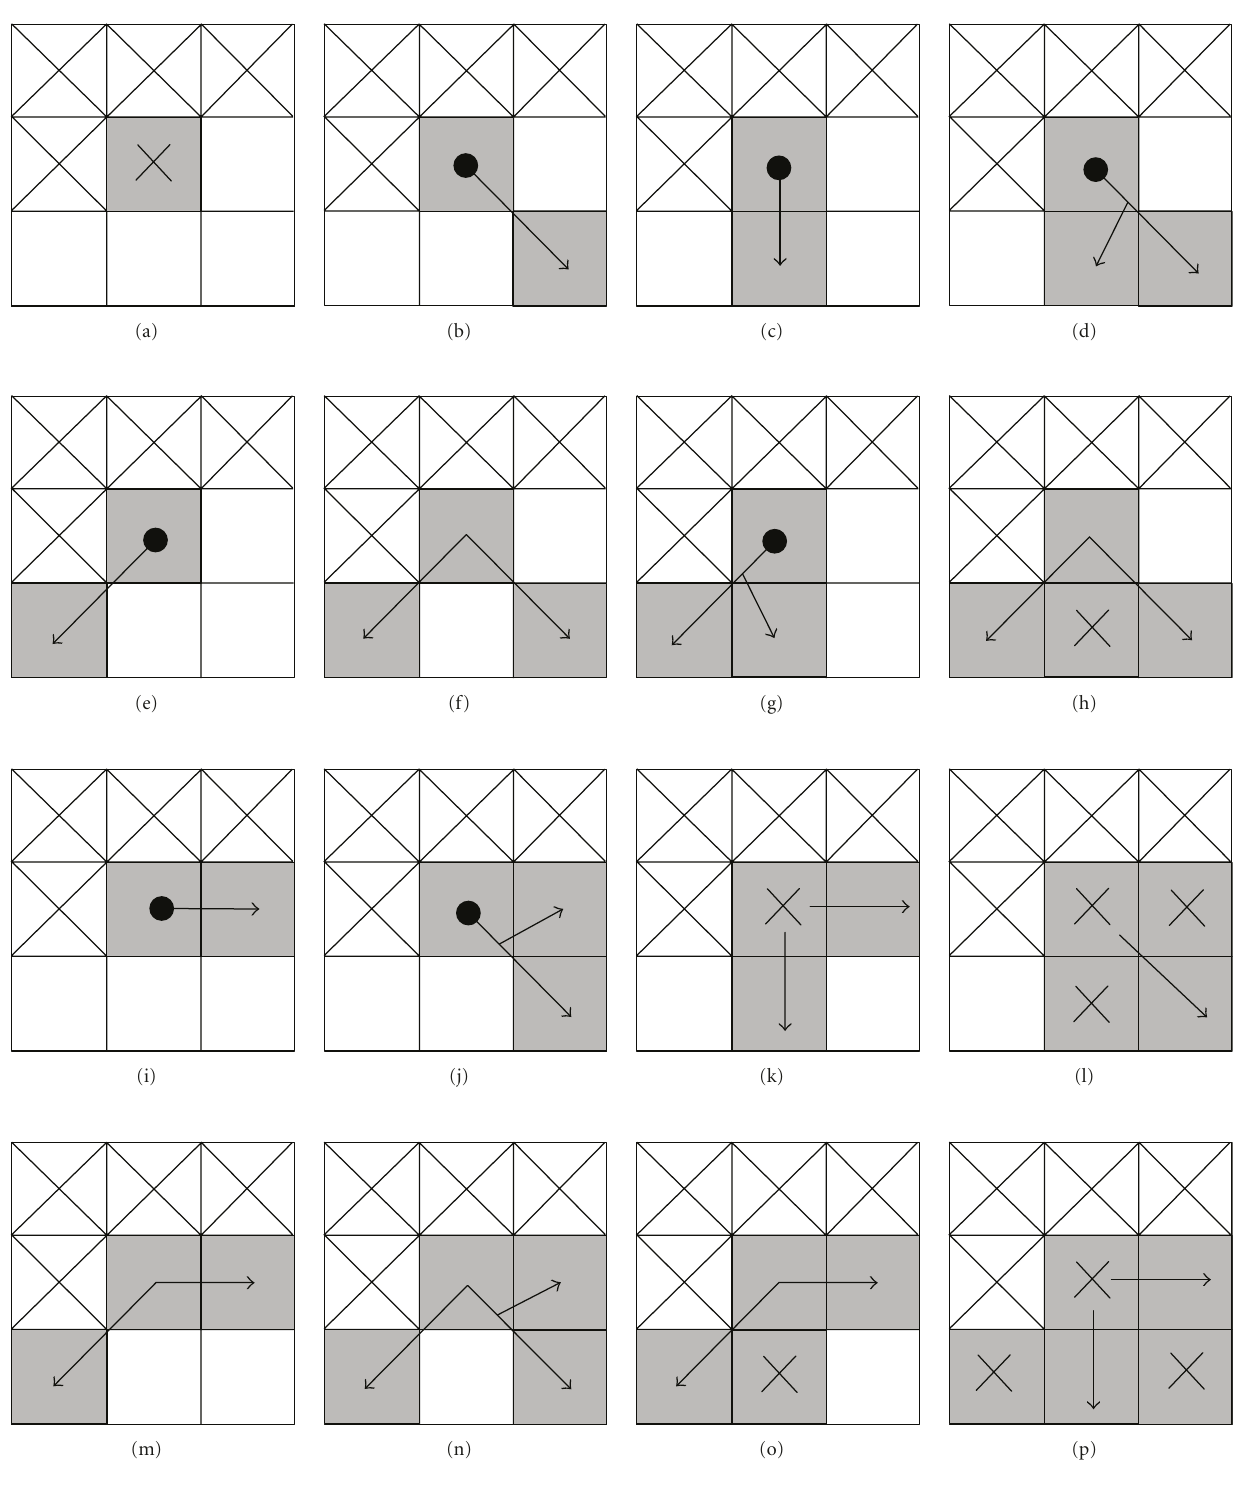
Figure 4: Initial tracking process for a segment depending on the neighbours pixels surrounding the first pixel found for the new segment in a 8-neighbourhood. As there are 4 neighbours not tracked yet (the bottom row and the one to the right), there are a total of 16 possible configurations. Gray squares represent crease (vessel) pixels and white ones background pixels. The upper row neighbours and the left one are ignored as they have already been tracked due to the image tracking direction. Arrows point to the next pixels to track while crosses flag pixels to be ignored. In (d), (g), (j) and (n) the forked arrows mean that only the best of the pointed pixels (i.e., the one with more new vessel pixels neighbours) is selected for continuing the tracking. Arrows starting with a black circle flag the central pixel as an endpoint for the segment ((b), (c), (d), (e), (g), (i),